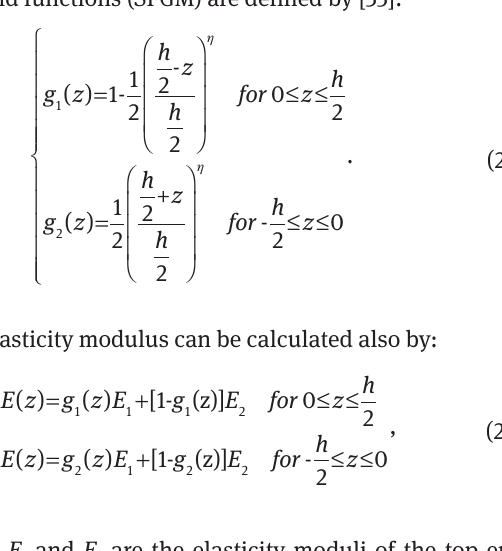
and E are the elasticity moduli of the top end where E 1 2 ( z = h /2) related to the titanium biometal and bottom end ( z = - h /2) related to HA bioceramic of the axial FGBM implant, respectively. For different values of η , the elastic- ity modulus along the longitudinal direction is plotted in Figure 2B. According to this figure, in the range from 0 to 0.5 of nondimensional length ( z/h ), the elasticity modulus decreases by reducing η , while in the range between -0.5 and 0 of nondimensional length ( z/h ), the reverse holds true. For the FE modeling of radial and axial FGBM implants, the variations of material properties were imple- mented by 20 layers in the radial and axial directions while the material properties for each layer were